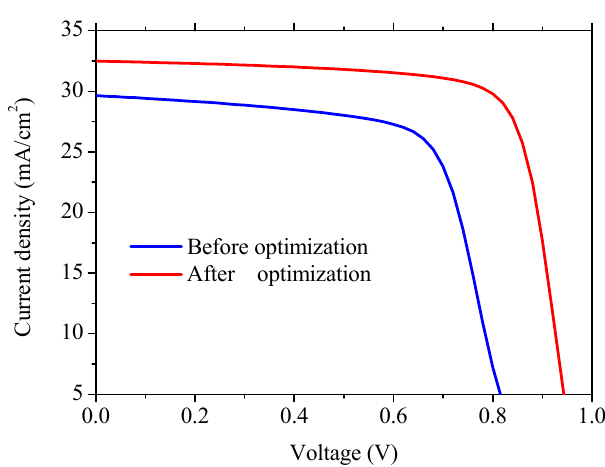
Figure 16. E ff ect of operating temperature. Figure 16. Effect of operating temperature.